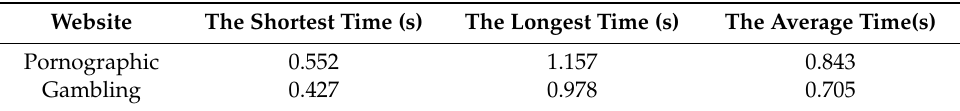
Table 10. Detection time of the proposed system.